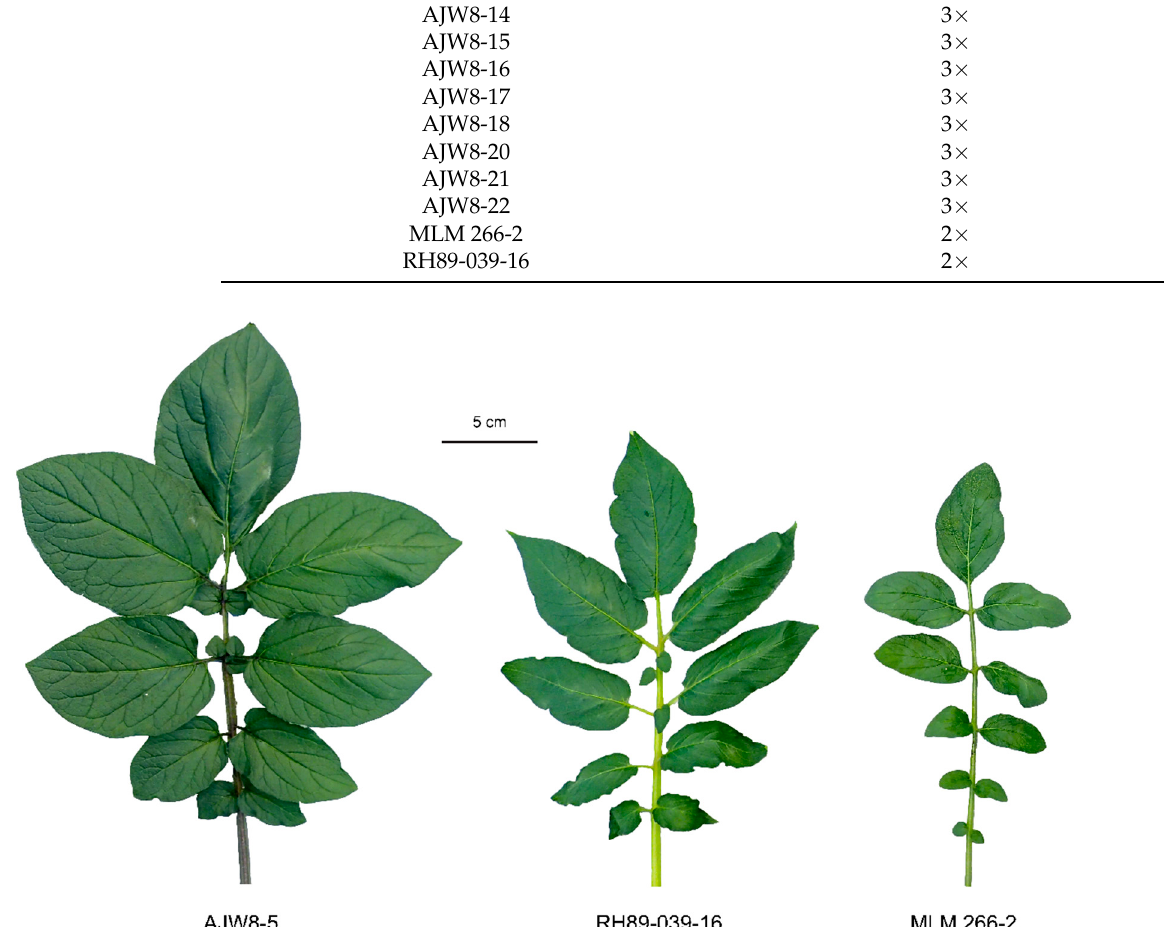
Figure 3. Enhanced vigour of triploid progeny genotype AJW8-5 from diploid S. commersonii subsp. malmeanum (MLM) 266-2 × diploid S. tuberosum RH89-039-16. Pictures are taken from the first fully expanded leaf from the top of 8-week-old plants. A leaf from representative progeny genotype AJW8-5 is shown next to leaves from parents RH89-039-16 and MLM 266-2. Table 3. A cross between diploid Solanum commersonii subsp. malmeanum (MLM) 266-2 and S. tu-